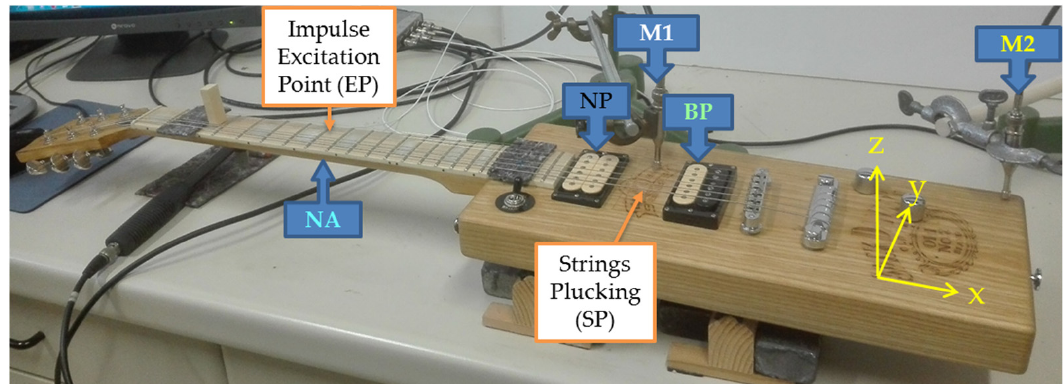
Figure 2. Test stand scheme for analysis of electric guitar behavior (guitar with body from walnut): EP—point of short, elastic impact excitation; SP—strings plucking, NA—position of neck accelerometer, NP—neck pickup, BP—body pickup, M 1 —body microphone, M 2 —edge body